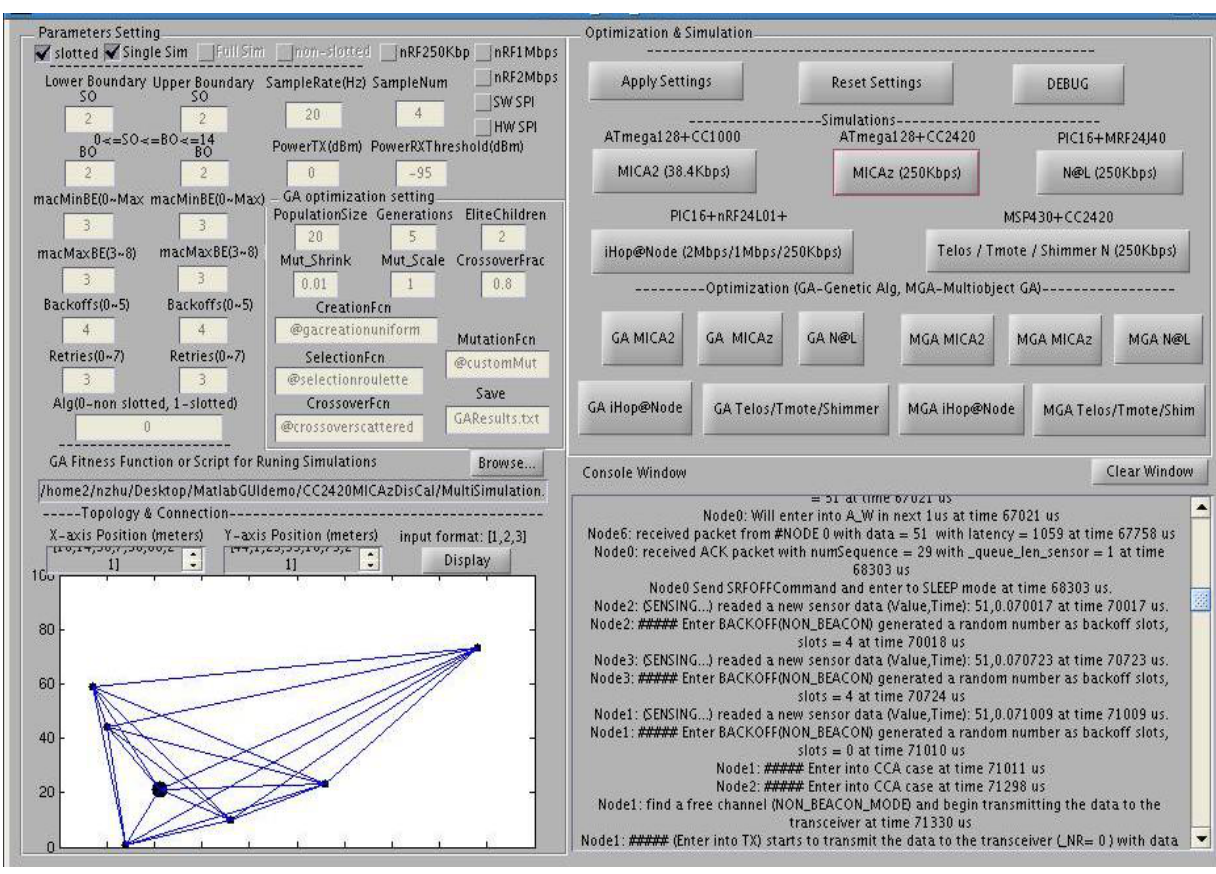
Figure 5. iMASKO